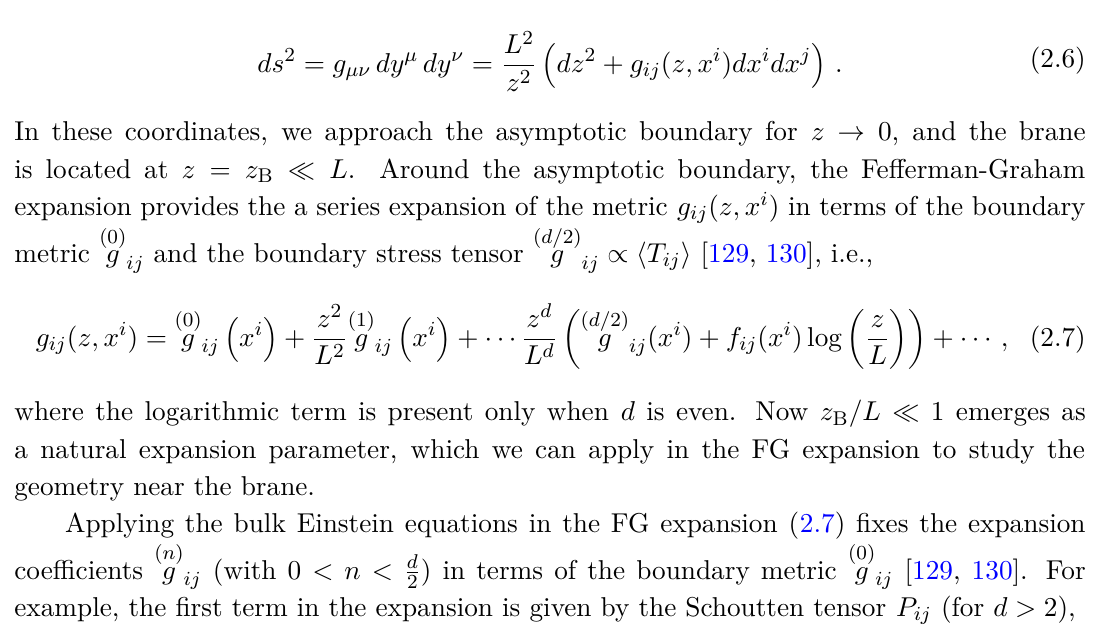
of the boundary subregion R = R R L ∪ R R crosses the brane, and the intersection L ∪B R L ∩ B R